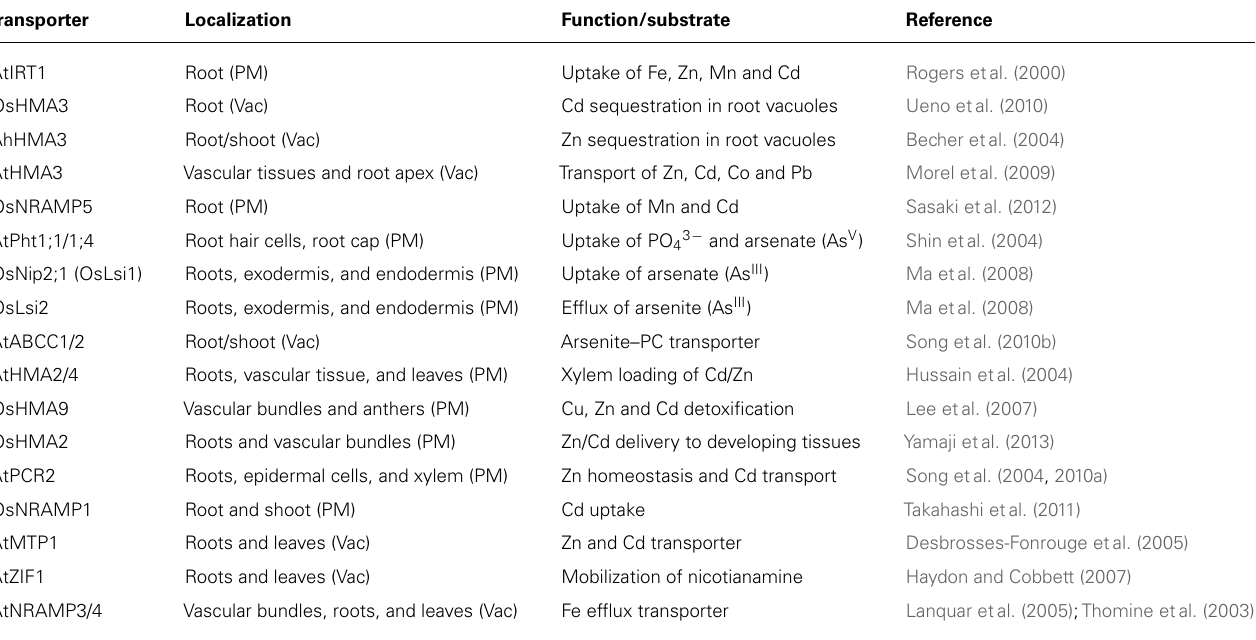
Table 1 |Transporters mediating the uptake and mobilization of arsenic or cadmium (discussed in this review).